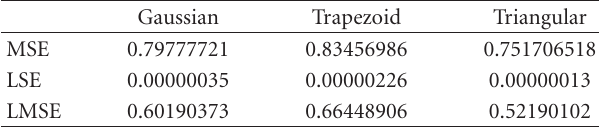
Table 3: Error calculation table: the tested